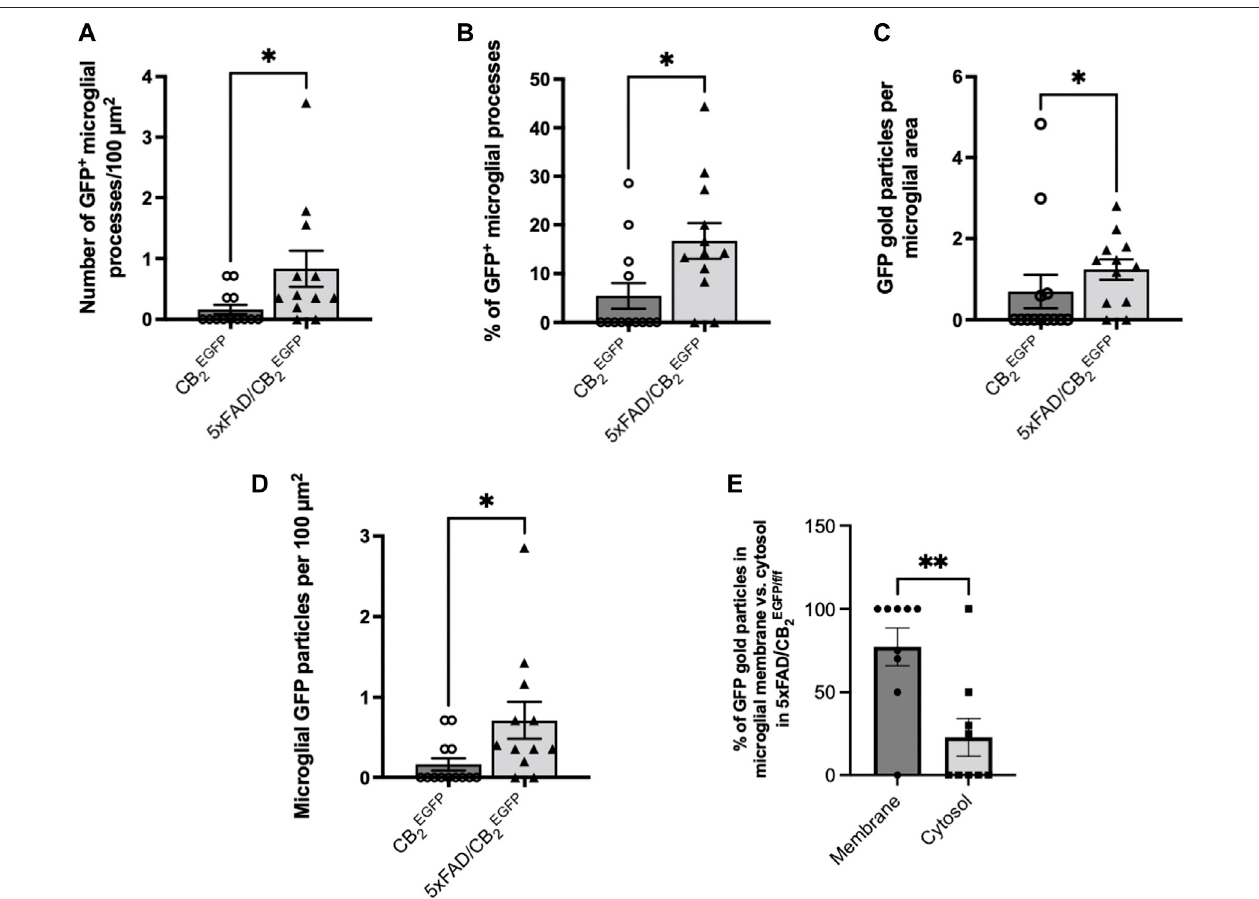
FIGURE 2 | Assessment of the microglial GFP/CB 2 localization in the subiculum of CB 2EGFP/f/f and 5xFAD/CB 2EGFP/f/f mice. (A) Number of microglial GFP-positive processes per 100 μ m 2 . (B) Percentage of GFP-positive microglial processes. (C) GFP gold particles per microglial area. (D) Microglial GFP particles per 100 μ m 2 . (E) Percentage of GFP particles in microglial membrane vs. cytosol in 5xFAD/CB 2EGFP/f/f mice. Mann-Whitney U test. * < p 0.05; ** < p 0.01; *** < p 0.001; **** < p 0.0001. N = 3 mice per group. Data represent mean ± SEM.